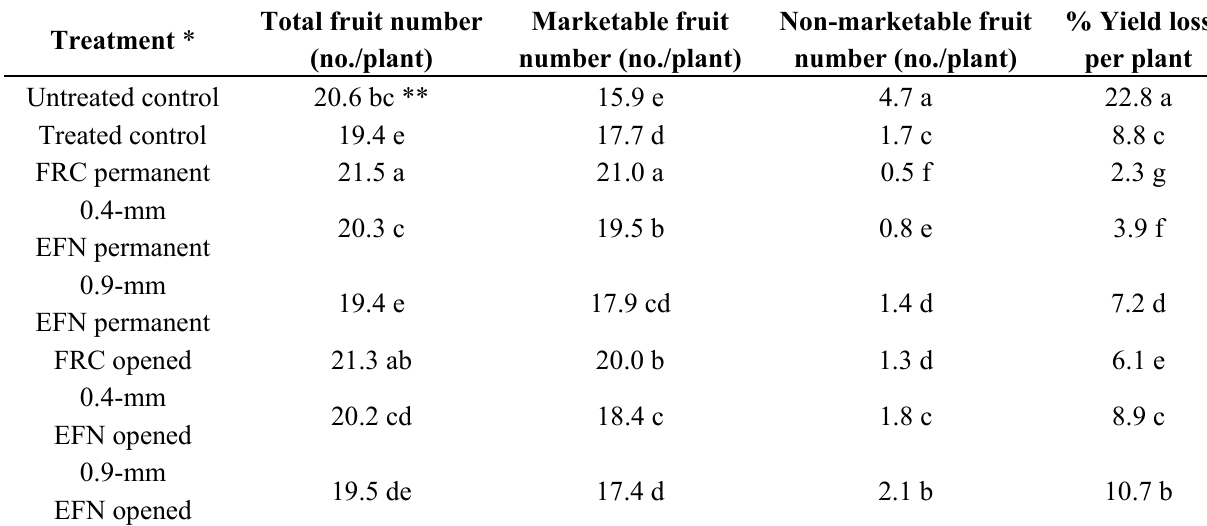
Table 2. Effects of floating row covers (FRC) and eco-friendly nets (EFN) on tomato yield (no./plant) during production. Values are averages of two growing seasons (May to October 2011 and October 2011 to March 2012).